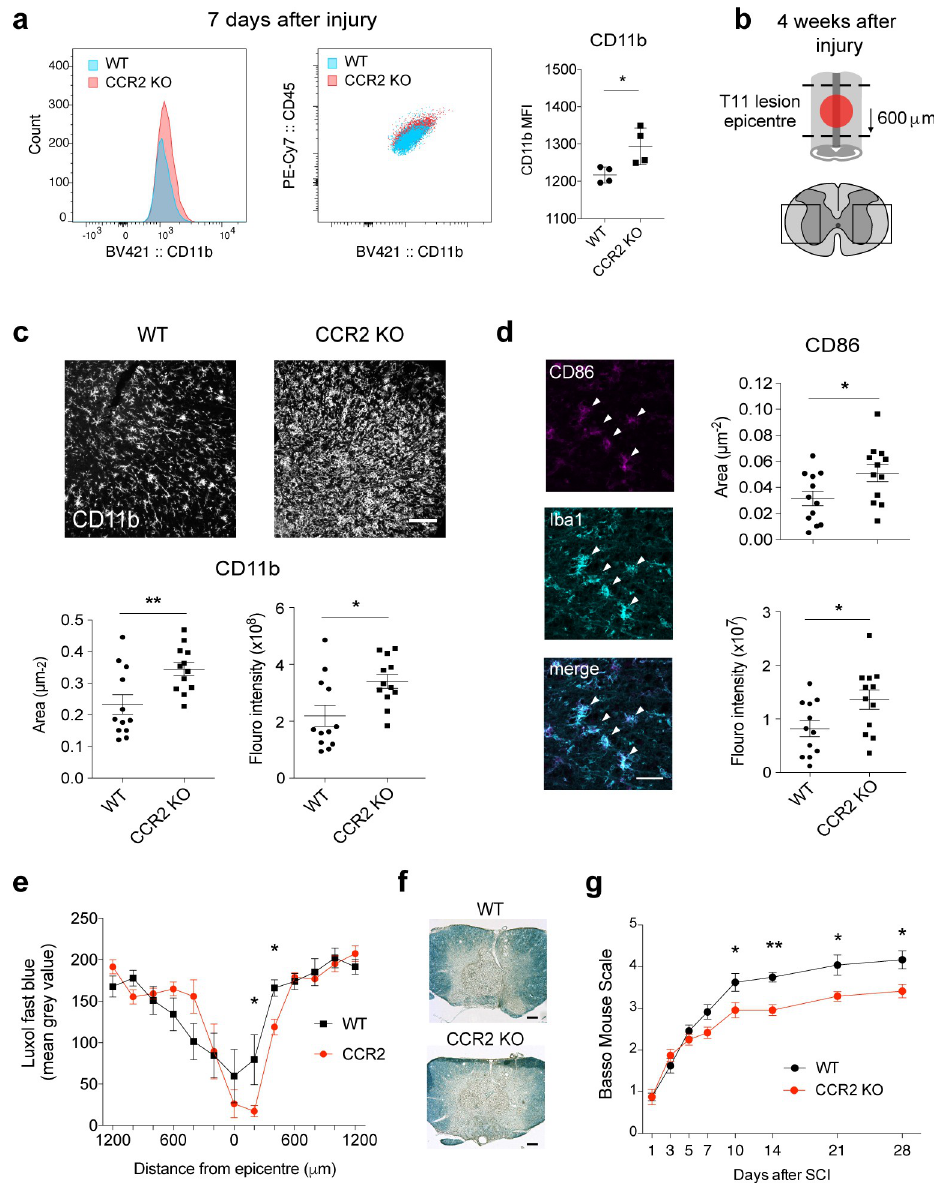
Fig 6. Blocking infiltration of macrophages to the injured spinal cord increases chronic microglial activation and impairs functional recovery after SCI. Spinal cord contusion injury was performed in CCR2 KO mice and WT controls. ( a ) FACS analysis of CD45 low /CD11b +ve /Ly6G − ve /Ly6C − ve microglia shows significant increase in CD11b mean fluorescent intensity (MFI) in CCR2 KO mice seven days after SCI. ( b ) Schematic of spinal cord shows area imaged and quantified in panels c and d , 28 days after injury—600 μ m caudal to T11 lesion and boxed regions in left and right lateral white and gray matter. ( c ) Representative images in WT and CCR2 KO of CD11b immunoreactivity 28 days after SCI. Graphs show CD11b average area ( μ m − 2 ) and fluorescent intensity (Integrated Density a.u) are significantly increased in CCR2 KO mice (which lack macrophage infiltration) versus WT controls. ( d ) CD86 expression (magenta) colocalized with Iba1 (cyan) is also significantly increased in CCR2 KO 28 days after SCI. ( e, f ) Luxol Fast Blue staining revealed that CCR2 KO mice showed greater myelin loss, a marker for secondary tissue damage, caudal to the lesion 28 days after SCI compared with control ( g ). Locomotor recovery assessed by the BMS shows CCR2 KO mice have impaired functional recovery compared to WT, beginning seven days after SCI. Statistical analysis for ( a, c, d, e ) Student t tests; a , n = 4; c and d , n = 12; e , n = 6 per group. ( g ) Two-way repeated measures ANOVA with post hoc Tukey analysis. n = 12 per group, mean ± SEM. � p < 0.05; �� p < 0.01. Scale bars in c and f = 100 μ m; d = 50 μ m. Corresponding raw data ( S1 Data ). BMS, Basso Mouse Scale; CCR2, C–C chemokine receptor type 2; FACS, fluorescently activated cell sorting; KO, knock-out; MFI, mean fluorescent intensity; SCI, spinal cord injury; WT,